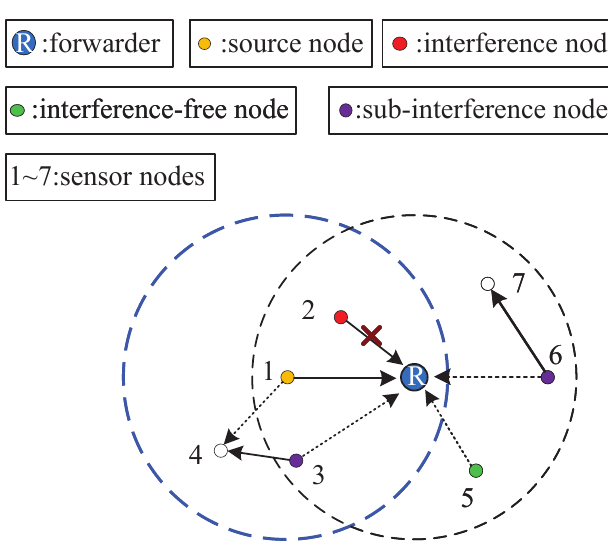
Figure 4. Interference determination scheme for DMAC.